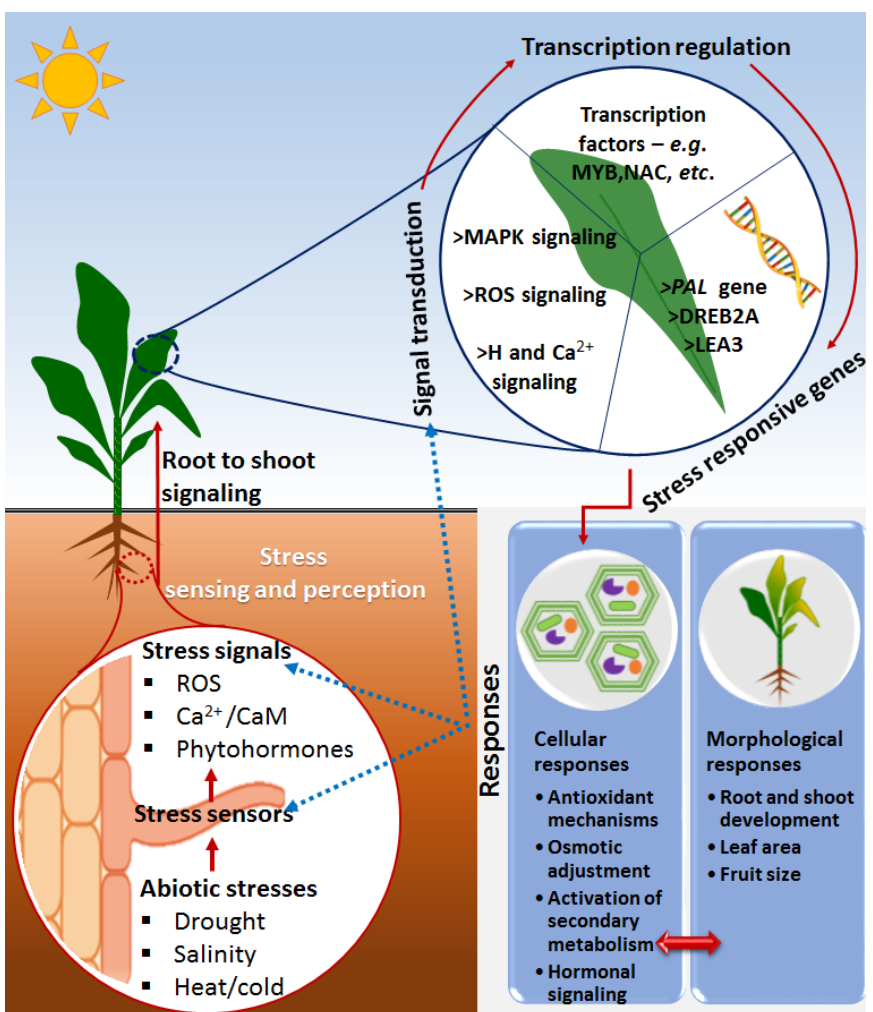
Figure 1. A descriptive model showing some general molecular events in a plant responding to abiotic stresses . Upon the perception of stress signals via evolutionarily developed rapid-sensing mechanisms, the systematic signal transduction/pathways such as ROS, Ca 2+ and phytohormone signals are activated, leading to regulation of stress-responsive genes as facilitated by transcription factors. The stress-related genes are (de)activated to orchestrate the induction of stress adaptation/resistance cellular mechanisms such as antioxidant mechanisms, osmotic adjustment and secondary metabolism adjustment, as well as morphological responses such as root and shoot development, leaf area and fruit size. The blue dotted lines indicate the influence of the stress responses to sensors, signals and signal transductions. Abbreviations: Ca 2+ = calcium ion, Ca 2+ /CaM = calcium calmodulin, ROS = reactive oxygen species, MAP kinases = mitogen-activated protein kinase, H = hormone, MYB = myeloblastosis, NAC = non-amyloid- β component, PAL = phenylalanine ammonia-lyase, DREB2A = dehydration-responsive element-binding protein 2A, LEA3 = late embryogenesis abundant 3.